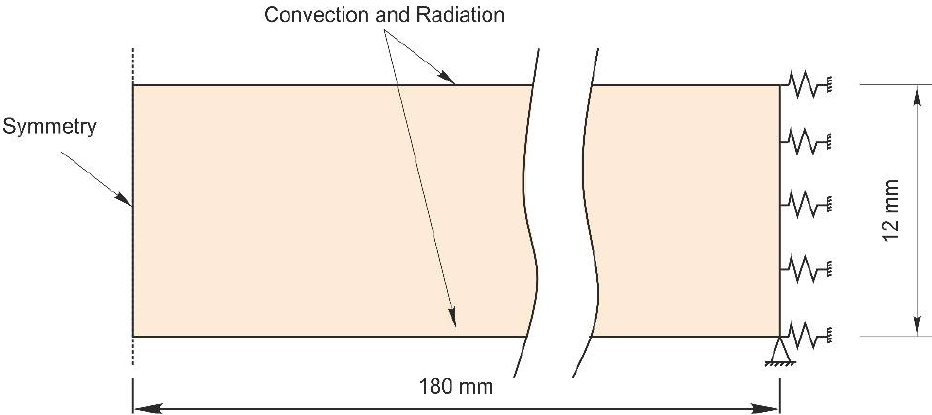
Figure 5. Boundary conditions used in the thermo-mechanical analysis.